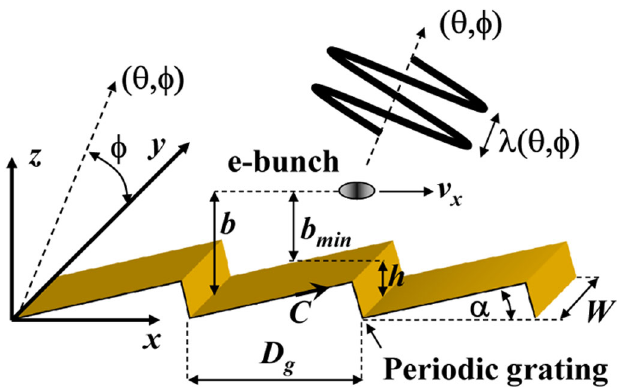
FIG. 1. (Color) The SPR scheme. An electron bunch is